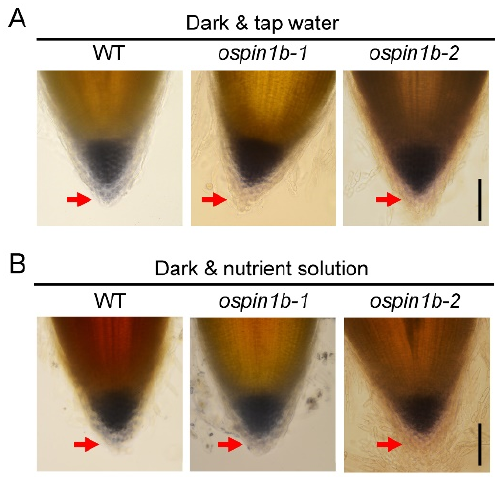
Figure 10. Amyloplast sedimentation analysis in wild-type (WT) and ospin1b root caps. ( A ) Rice plants were cultured with tap water in the dark. ( B ) Rice plants were cultured with a nutrient solution in the dark. The red arrow indicates the peripheral tiers of the root cap columella cell. Bar = 0.1 mm.